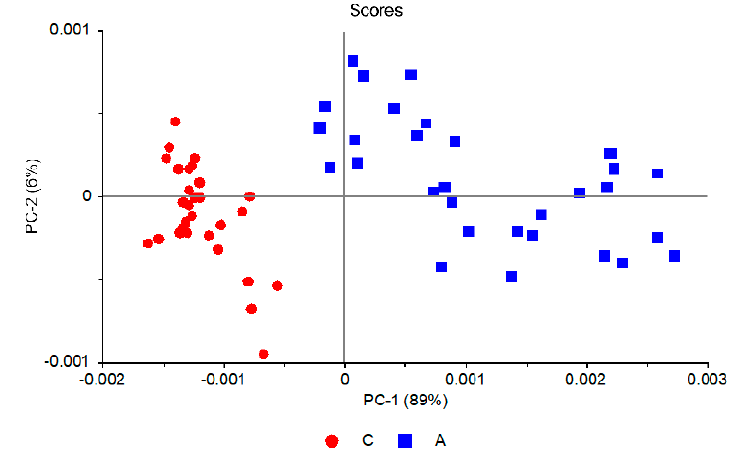
Figure 9. Scores plot (PC-2 vs. PC-1) for the PCA done using all 59 samples.